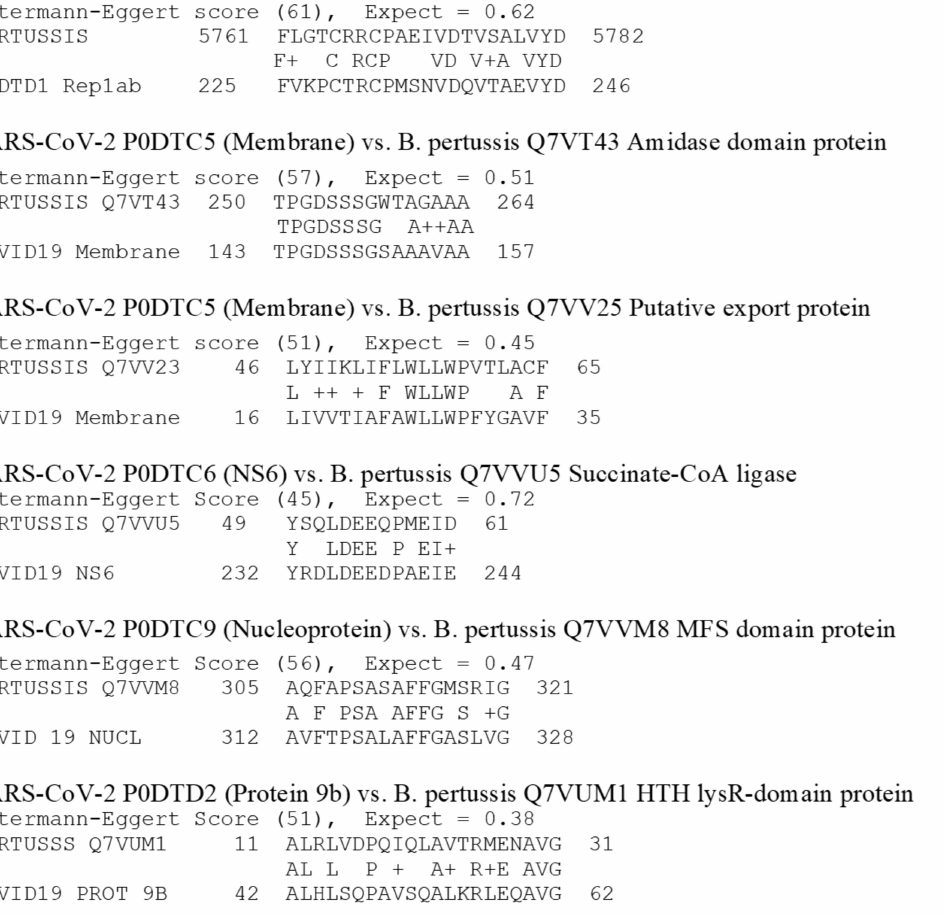
Figure 4. SARS-CoV-2 protein similarities with Bordetella pertussis polyprotein (UniProte accession number UP000002676). Note that whole B. pertussis is used as a vaccine. It is composed of